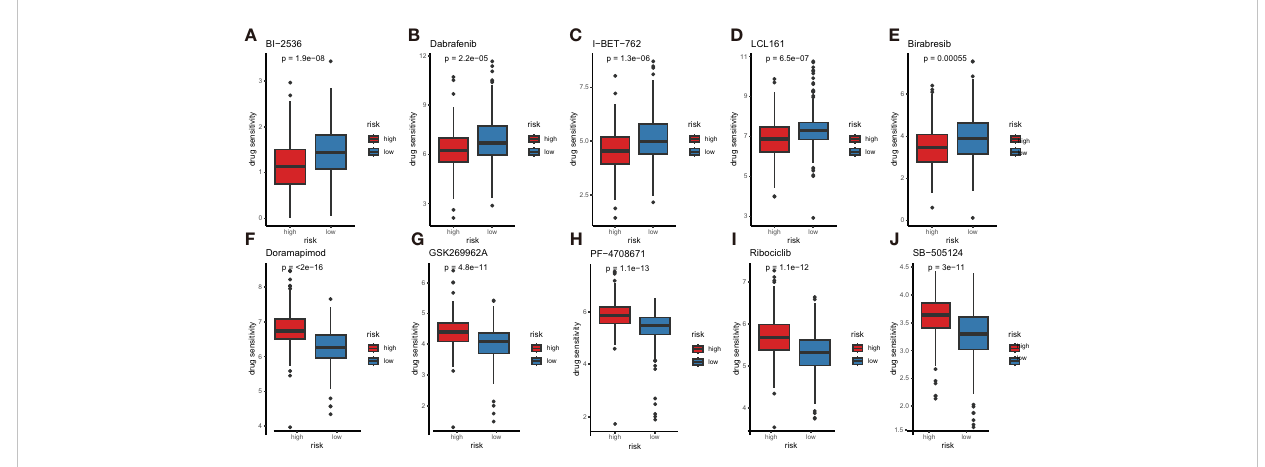
FIGURE 12 Comparison of anti-tumor drug sensitivity between the high- and low-risk subtypes. (A) BI-2536, (B) dabrafenib, (C) I-BET-762, (D) LCL-161, (E) Birabresib, (F) doramapimod, (G) GSK269962A, (H) PF-4708671, (I) ribociclib, (J) SB-505124.